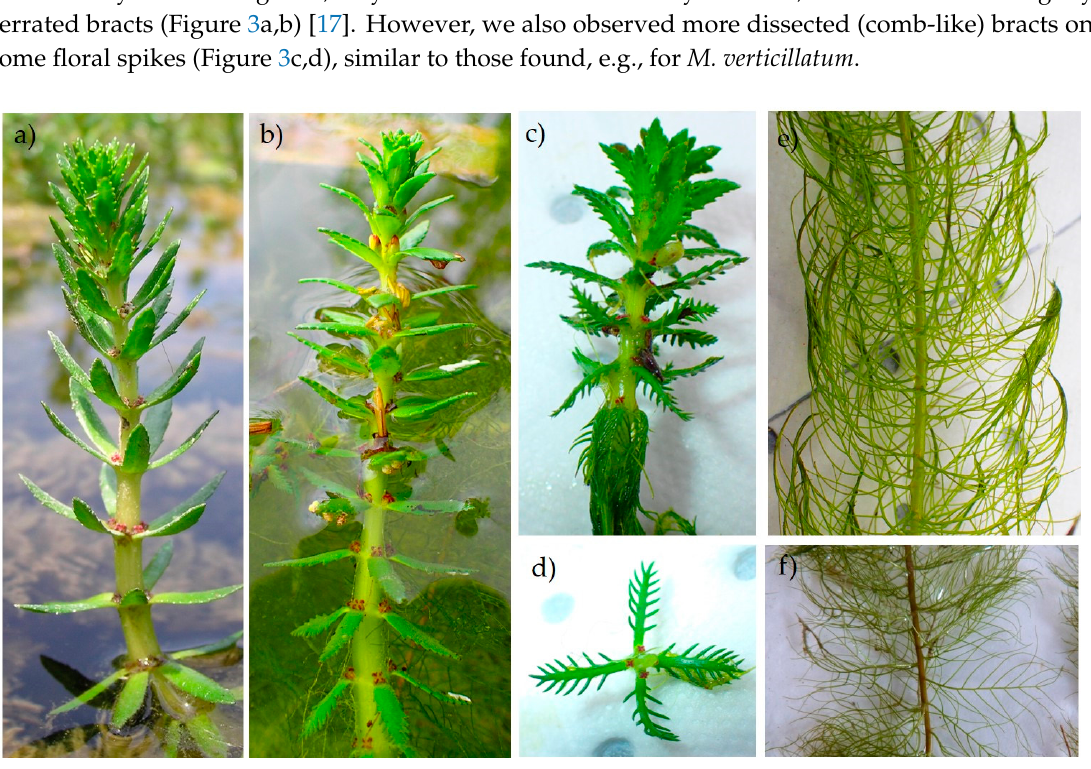
Figure 3. Morphological characteristics of Myriophyllum heterophyllum . ( a – d ) floral spikes with bracts and red stigmata; please note the different form of the bracts; for details, see text. ( e , f ) shoot section with detail of leaves slightly offset within a whorl (Photos ( a ) A. Hussner, ( b – e ) C. Pestelard, ( f ) N. Dubost).